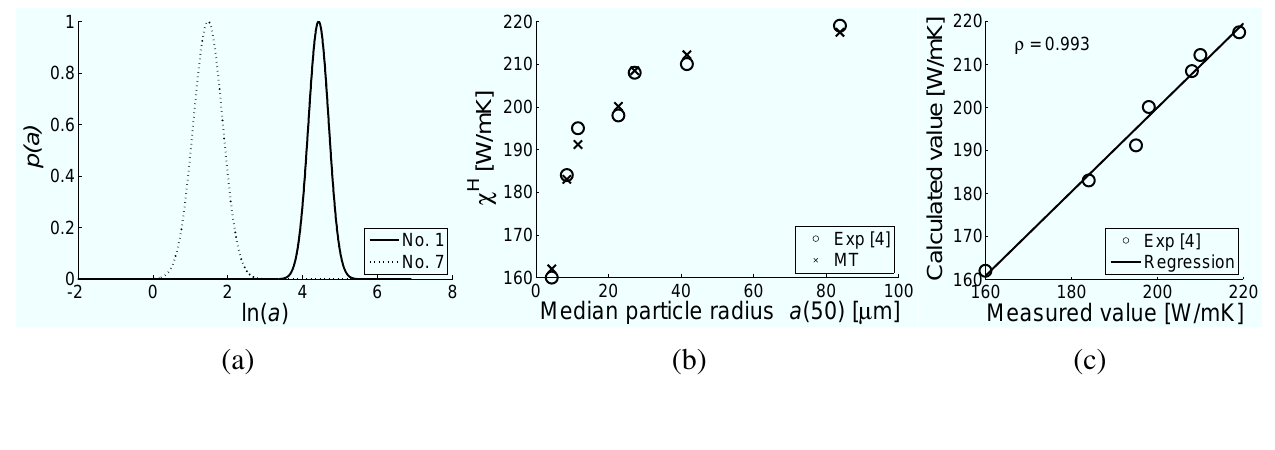
No. 1 and 7, ( b ) evolution of effective thermal conductivity χ H as a function of particle radius a , ( c ) correlation of measured and calculated values; ρ denotes the correlation